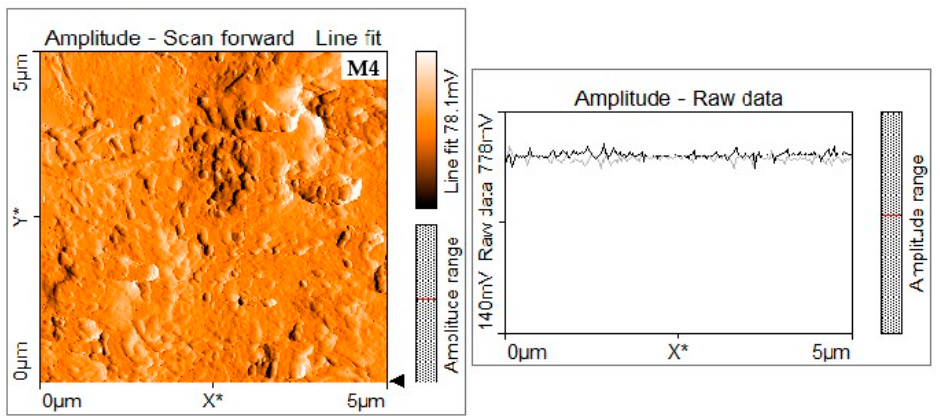
Figure 5. Atomic force microscopy (AFM) images of the obtained membranes with different concentrations of KIT-6 and KIT-6-NH 2 nanoparticles.